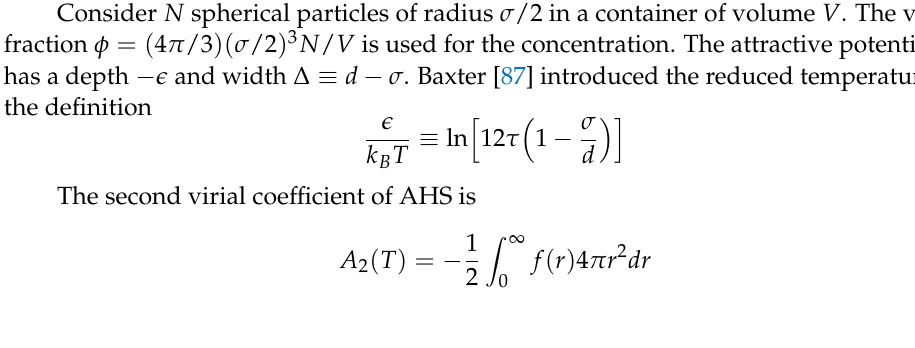
Figure 5. ( a ) Interacting adhesive hard spheres, ( b ) Baxter potential, ( c ) patchy hard spheres iteracting by adhesive Baxter force, ( d ) functional molecules employed by Flory–Huggins gelation model. Functional groups (dark spheres) on the surface of molecules interact by adhesive Baxter